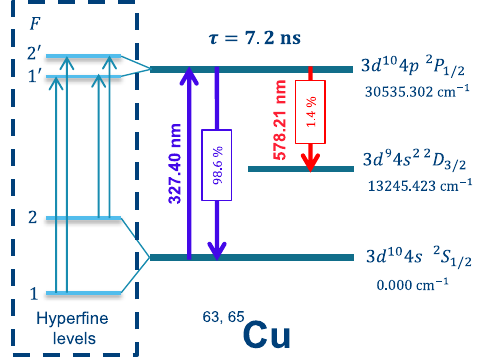
FIG. 5. Atomic levels and their hyperfine splitting (not to scale) in the stable 63 ; 65 Cu